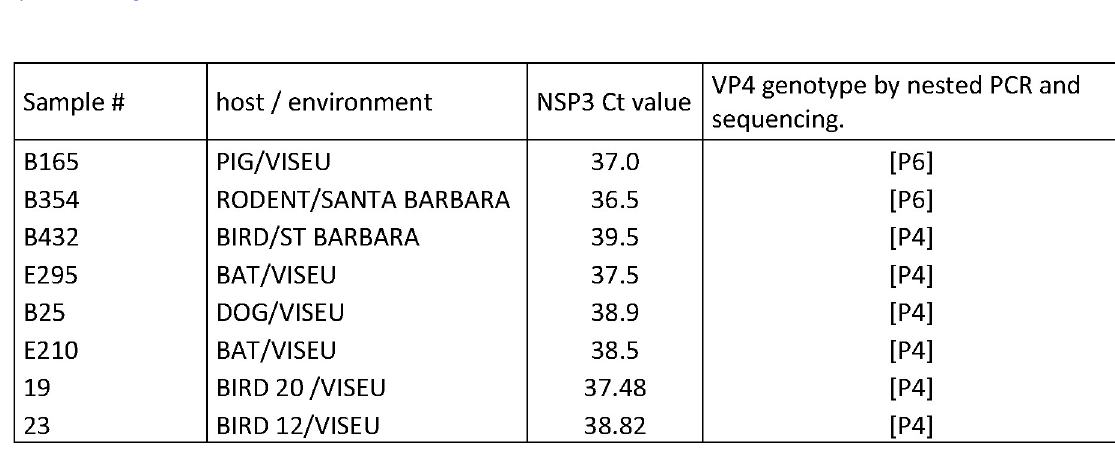
PLOS ONE | https://doi.org/10.1371/journal.pone.0209005 December18, 2018 11 /